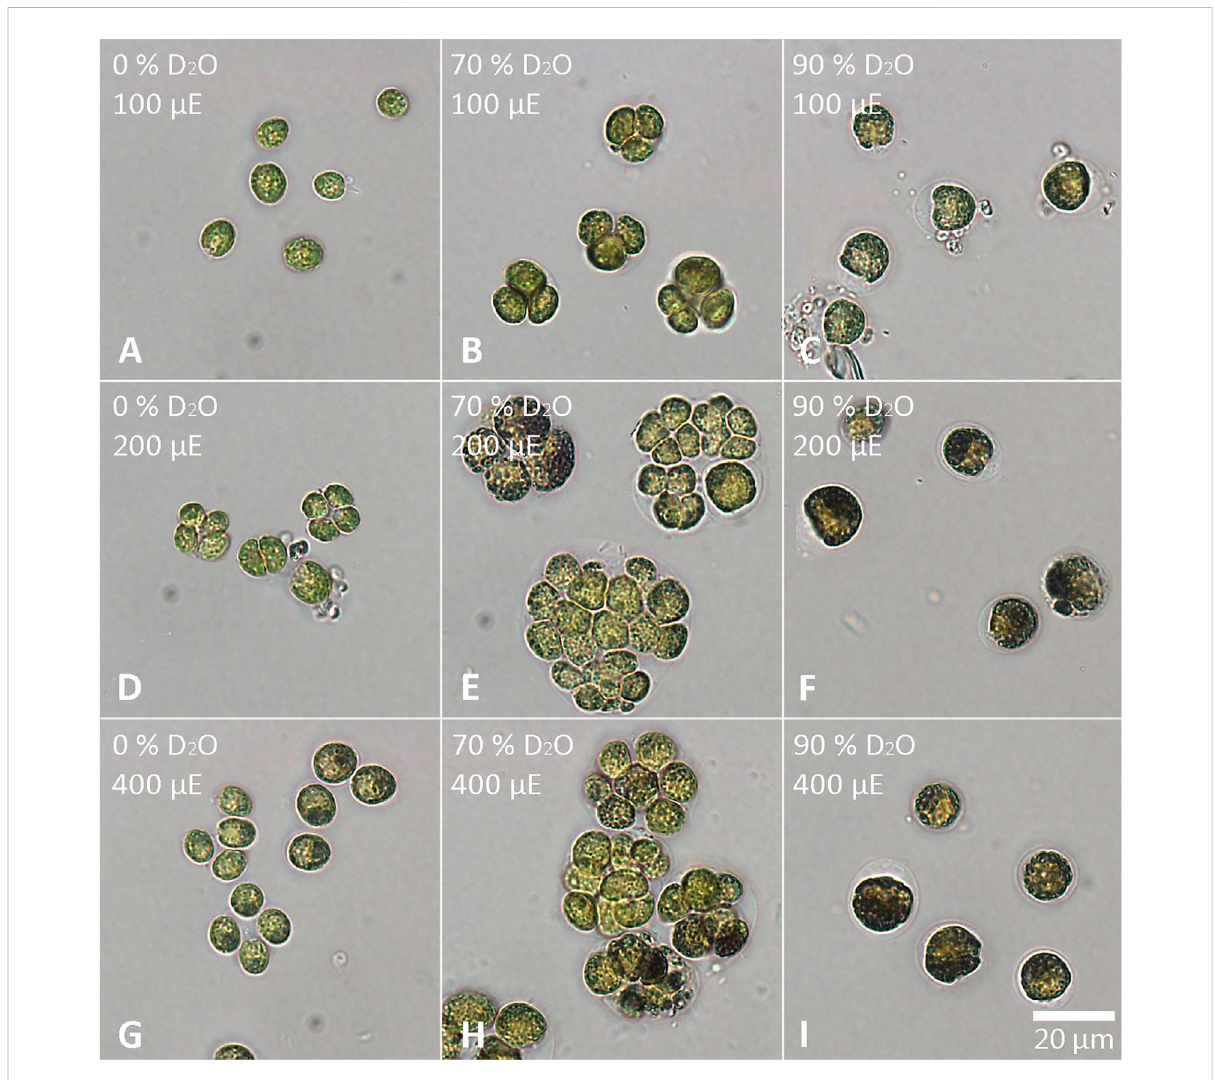
FIGURE 7 Staining of C. reinhardtii with Lugol ’ s solution. Cells grown in 0 (A,D,G) , 70 (B,E,H) or 90% (C,F,I) D2O (from left to right) at an incident light intensity of 100 (A,B,C) , 200 (D,E,F) or 400 (G,H,I) μ mol photons · m − 2 · s − 1 (denoted as μ E in the fi gure; from top to bottom) were stained after 48 h of cultivation. The starch granules appear dark purple to